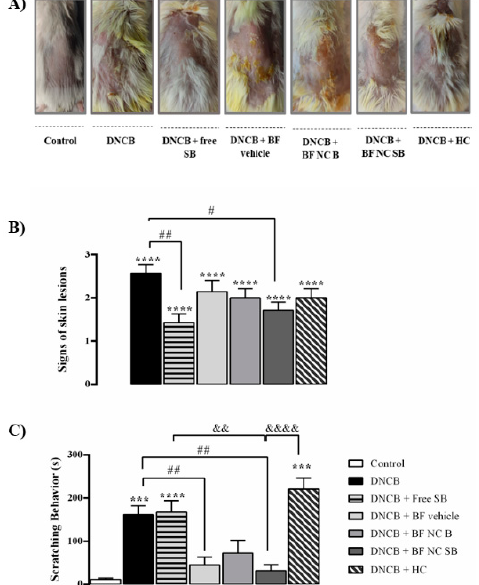
Figure 5. Effect of the different treatments on AD-like clinical signs induced by DNCB in mice. ( A ) Images of the skin lesions from the groups of mice taken on the last day of the experiment (day 31). ( B ) Score of the skin lesions. ( C ) Scratching time evaluated on day 30 of the experimental protocol. Each column represents the mean ± SEM of 7 mice per group. (****) p < 0.0001 and (***) p < 0.001 compared with the control group, (##) p < 0.01 and (#) p < 0.05 compared with the DNCB group, (&&&&) p < 0.0001 and (&&) p < 0.01 compared with the BF NC SB group (One-way ANOVA followed by the Tukey’s